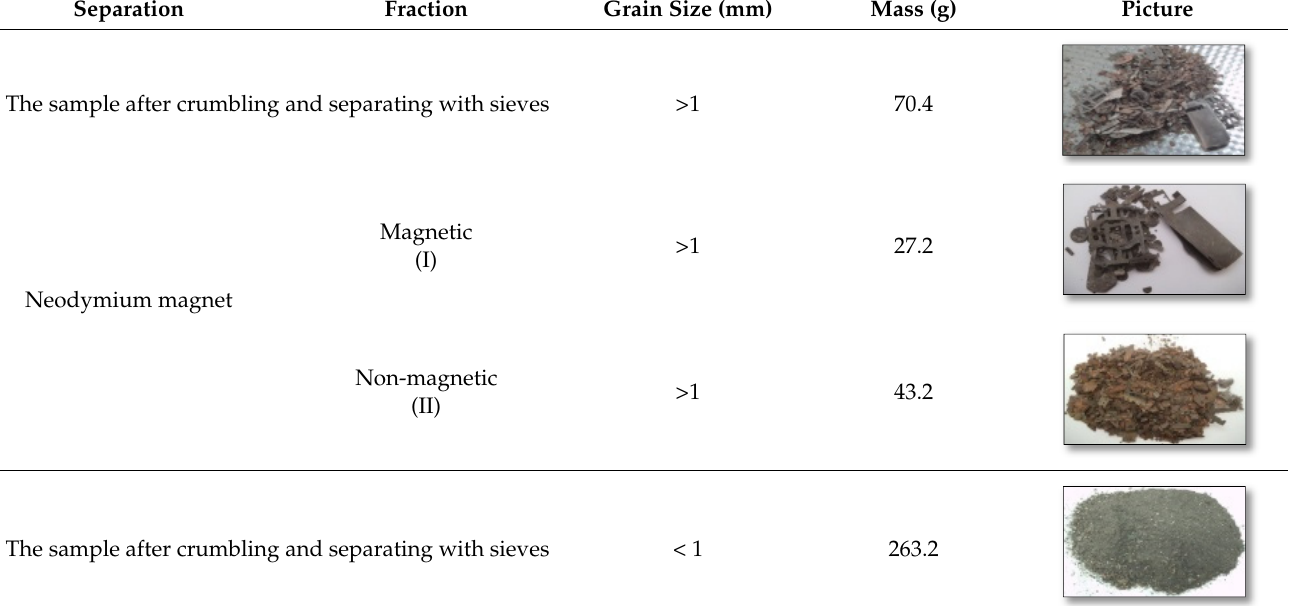
Table 8. Received fractions after magnetic enrichment processes.